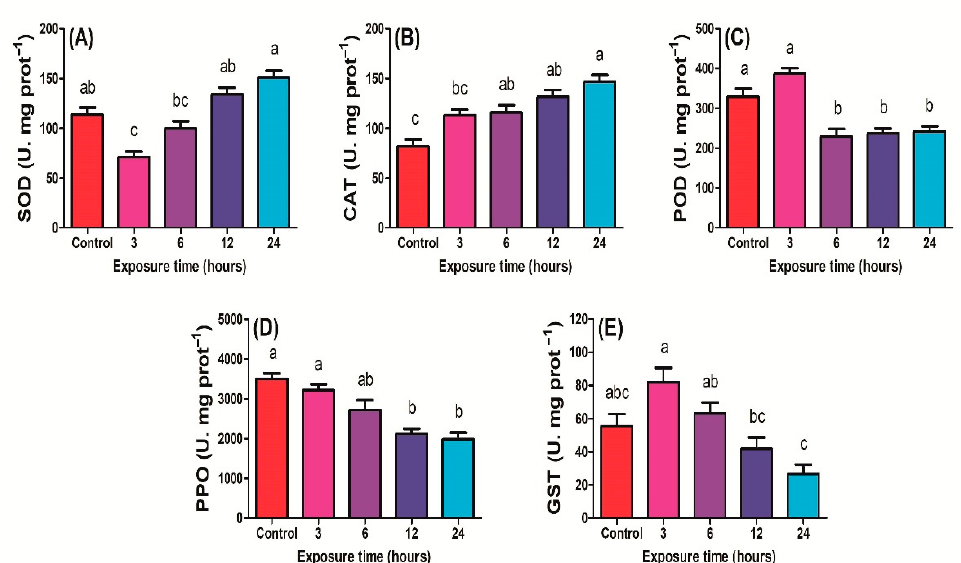
Figure 1. Activities of different antioxidant enzymes ( A ) SOD, ( B ) CAT, ( C ) POD, ( D ) PPO, and ( E ) GST of Plutella xylostella larvae exposed to UV − light for control (0 h), 3, 6, 12, and 24 h. The bars indicate the mean values of four replications. Standard error bars indicate the standard deviation of the mean. Lowercase letters indicate the significant difference among the treatments at P < 0.05. Similar letters have no significant difference among treatments.